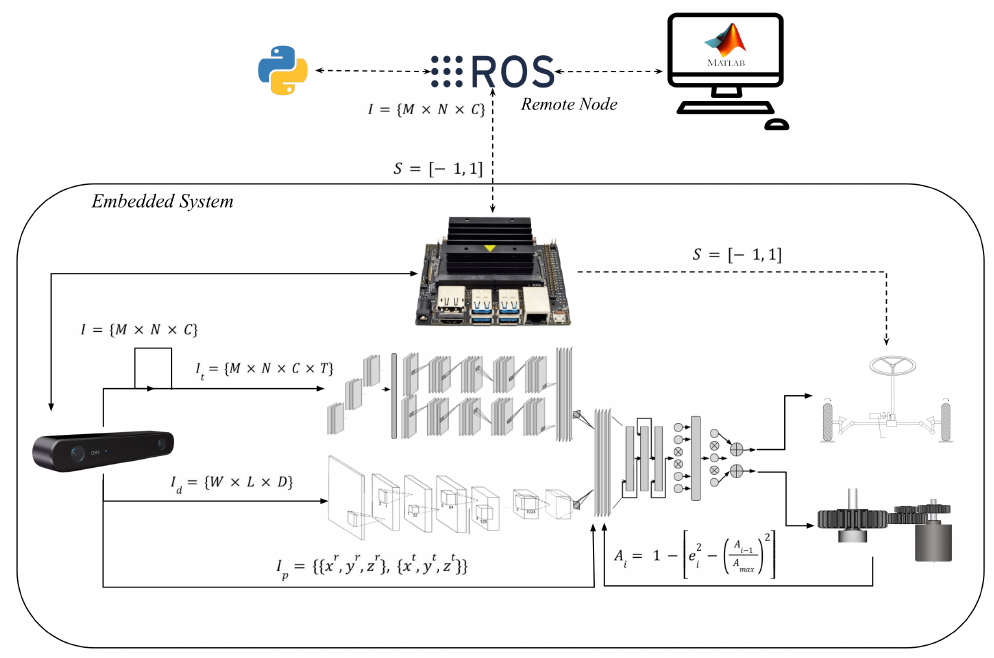
Figure 10. Embedded self-driving system operational diagram and remote interaction for comparison methods evaluation.